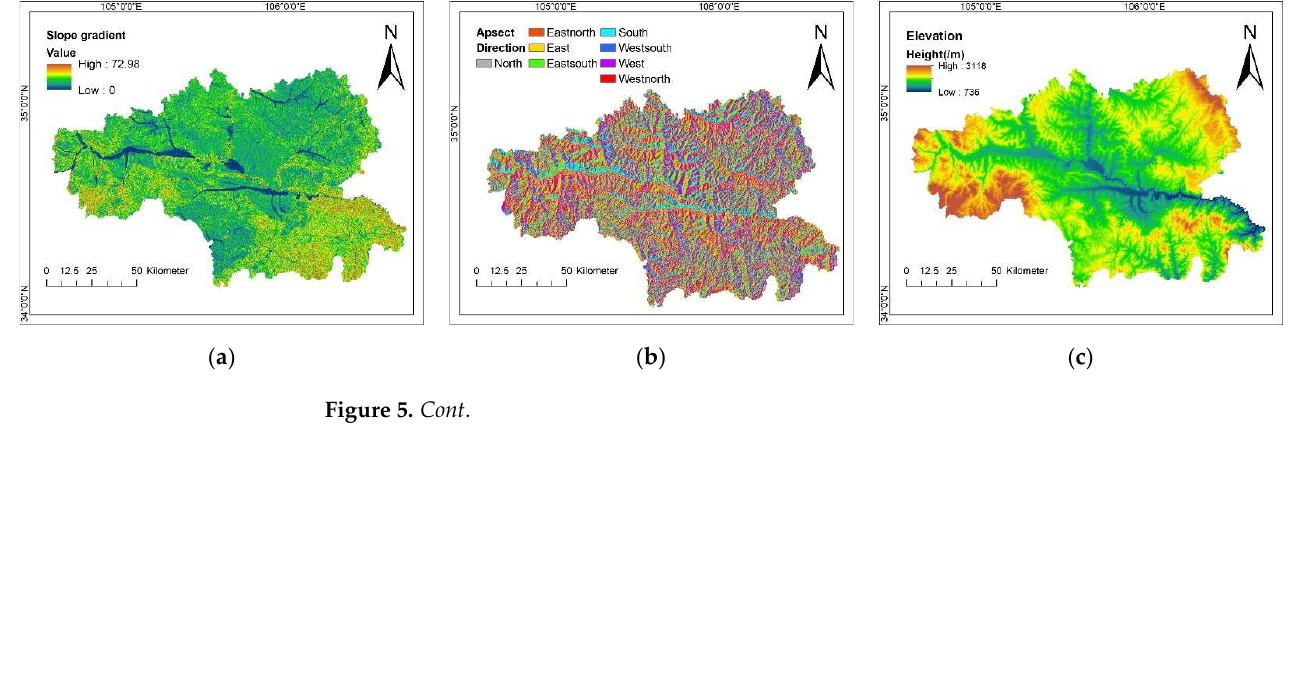
Figure 4. Graphics of sampling datasets, positive points represent the geohazard points: ( a ) Landslide; ( b ) Collapse; ( c ) Unstable slope.